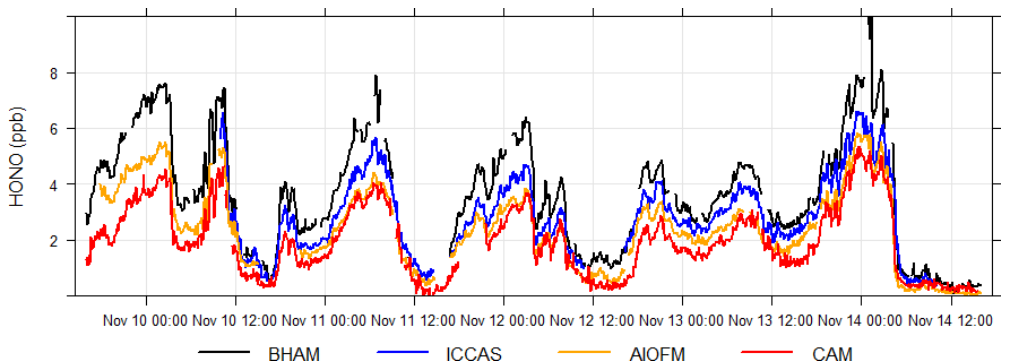
Figure 1. Time series of the measured mixing ratios during the formal winter intercomparison for each instrument. Time zone is local time, China standard time